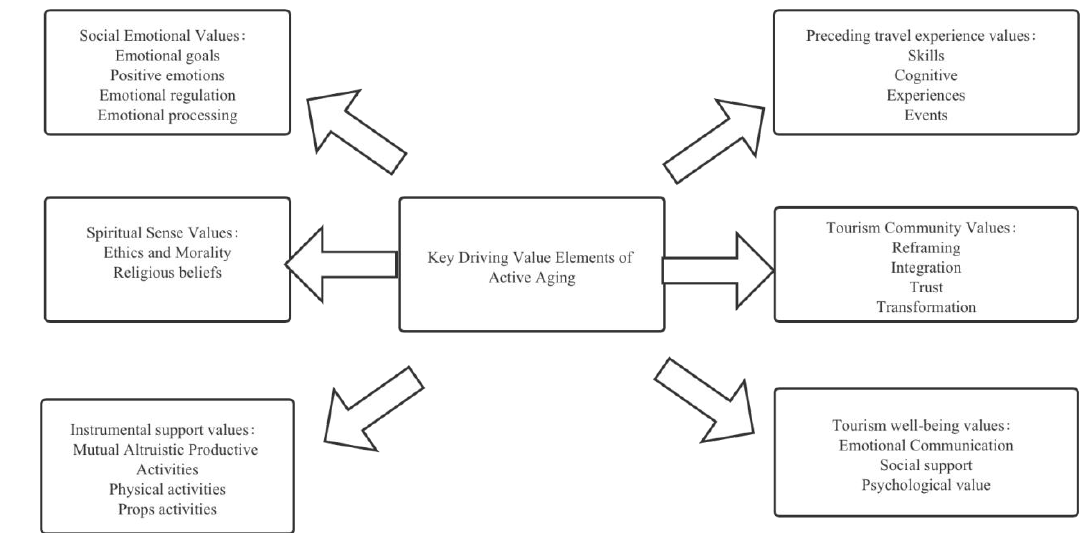
Figure 3. Key driving value elements of active